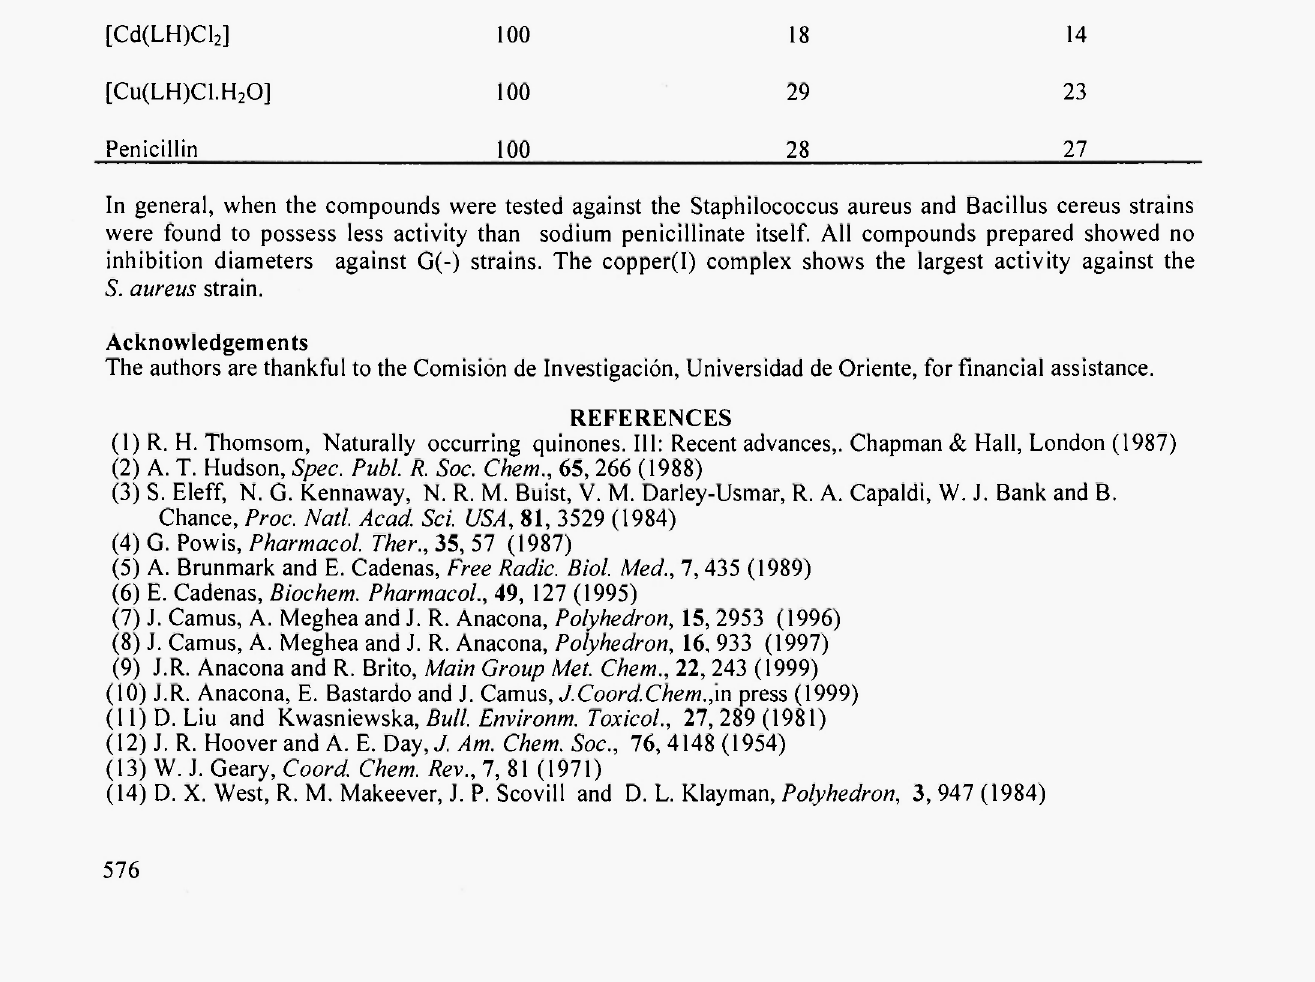
Table 2. Antimicrobial Activity Compound ΜG /disc S.